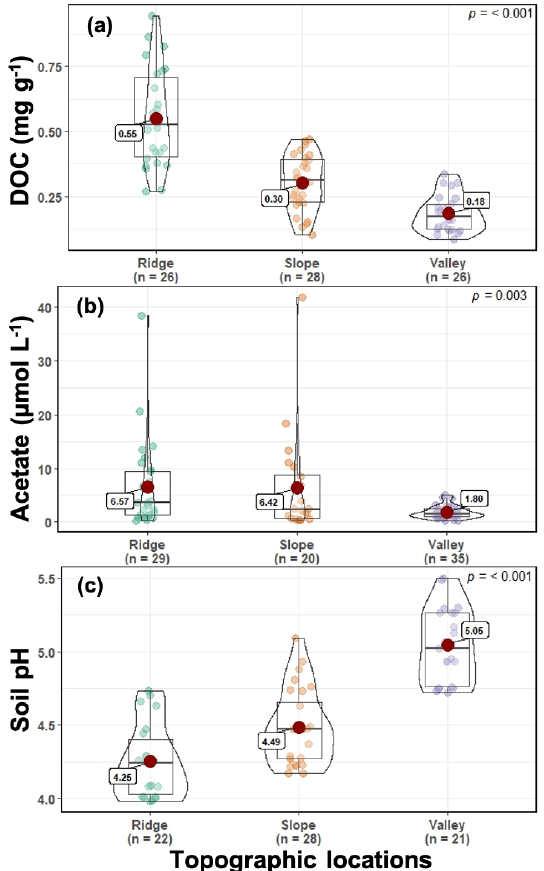
Figure 2. Soil and porewater chemistry (dissolved organic carbon [DOC], a ; acetate, b ; and pH, c ) along the ridge–slope–valley topo- graphic